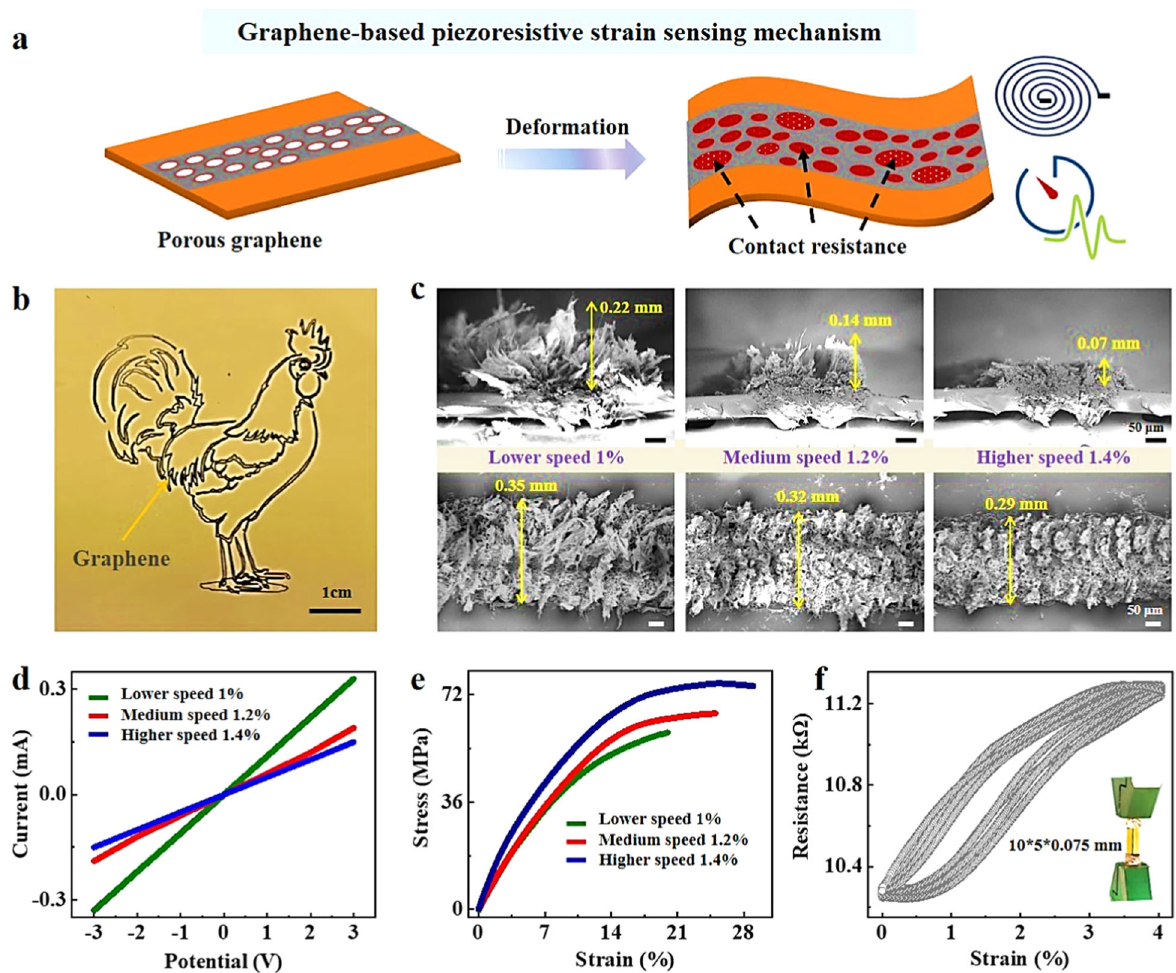
Fig. 2 Graphene-based strain sensing unit fabricated by laser reduction. a Mechanism of graphene-based piezoresistive strain sensing. b A cock pattern obtained from laser reduction on PI. c SEM cross-section and surface images of the graphene-based strain sensor. d I – V curves of the graphene-based strain sensor (20*5*0.075 mm) with different laser speeds. e Strain – stress curves. f Cyclic test of the strain-resistance curve (laser speed 1%, power 0.3%, PPI